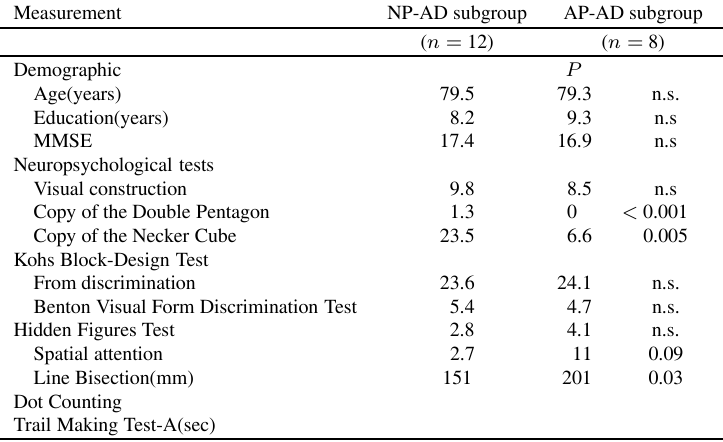
Table 2 Neuropsychological performances of two subgroups of